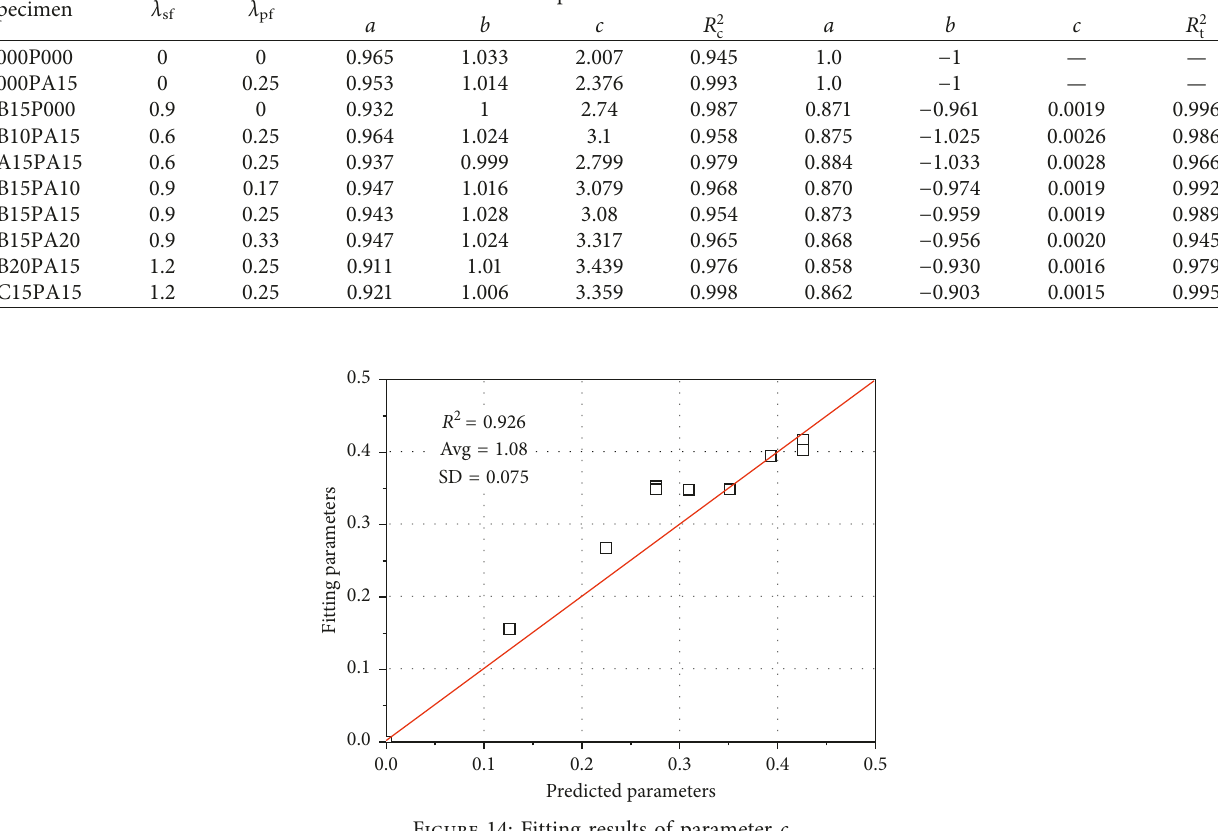
Figure 14: Fitting results of parameter c